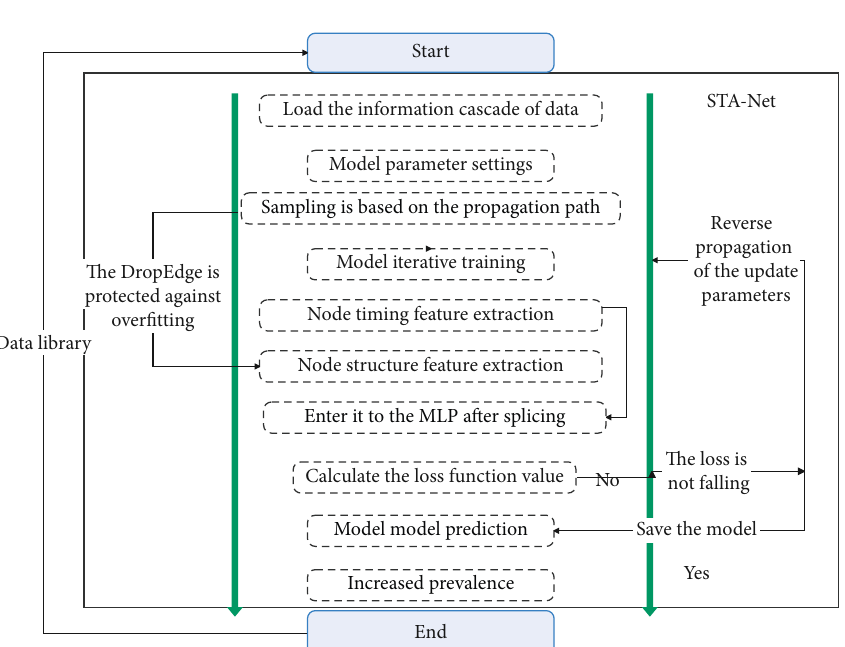
Figure 6: Information popularity prediction